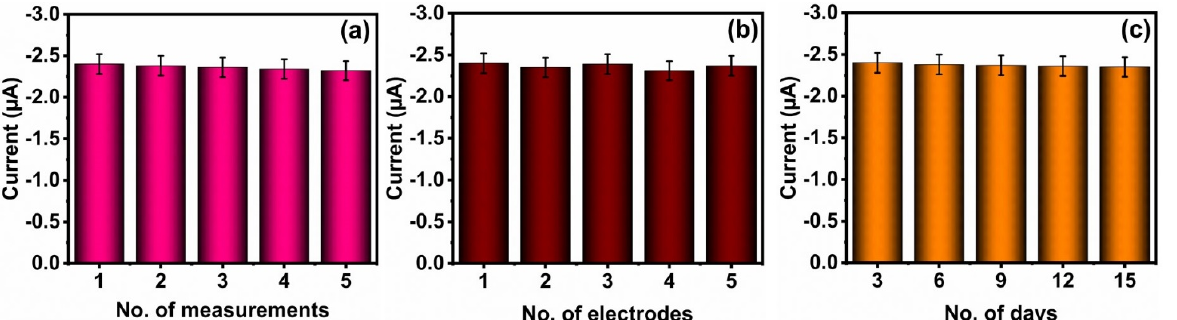
Figure 10. ( a ) The bar diagram for the current response of a single NMO/GCE for five repetitive measurements in 100 µM of FZE in 0.1 M PB (pH 7.0) at a scan rate of 50 mV s − 1 , ( b ) The bar diagram for the current response of five independent NMO/GCE measurements at 100 µM of FZE in deoxygenated 0.1 M PB (pH 7.0) at a scan rate of 50 mV s − 1 , and ( c ) The bar diagram for the long-term stability of NMO/GCE over 15 days. Table 2. The determination of FZE in human serum and urine samples using NMO/RGO. Real Sample Added ( µ M) Found ( µ